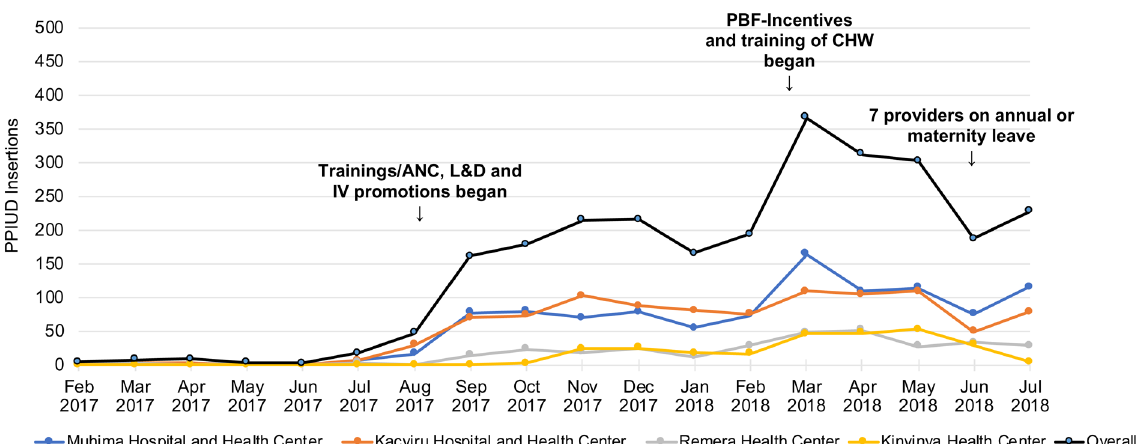
Figure 2. PPIUD insertions over time by facility (N = 2,575 total PPIUD insertions). Percent increase in monthly insertions comparing February 2017-July 2017 to August 2017-July 2018: 2,687%. PPIUD: postpartum intrauterine device; CHW: community health worker; PBF: performance-based financing; ANC: antenatal care; L&D: labor and delivery; IV: infant vaccination.